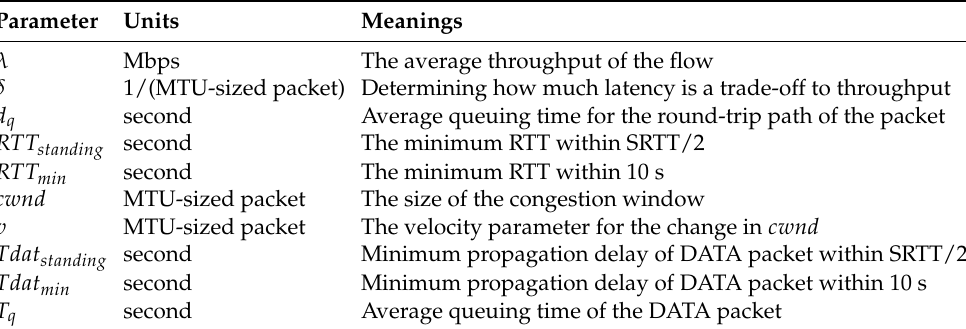
Table 1. Units and meanings of main